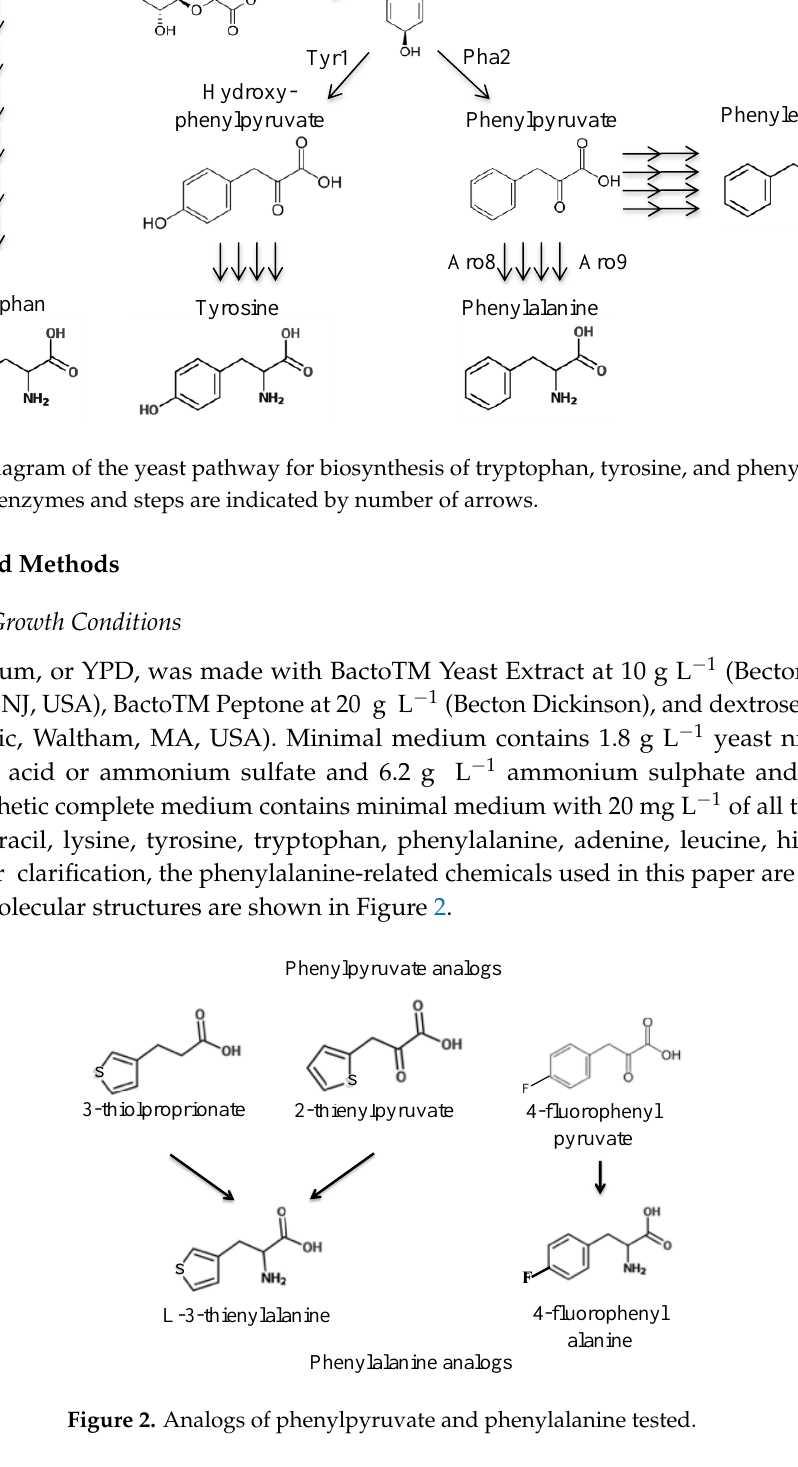
Figure 2. Analogs of phenylpyruvate and phenylalanine tested.